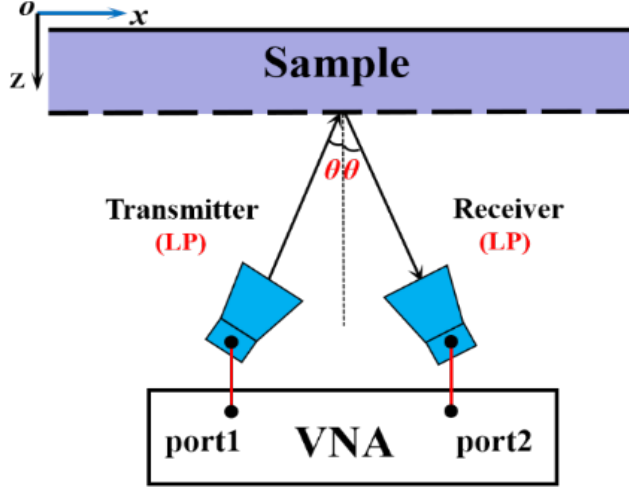
Figure 12. Structure diagram of the measurement setup.